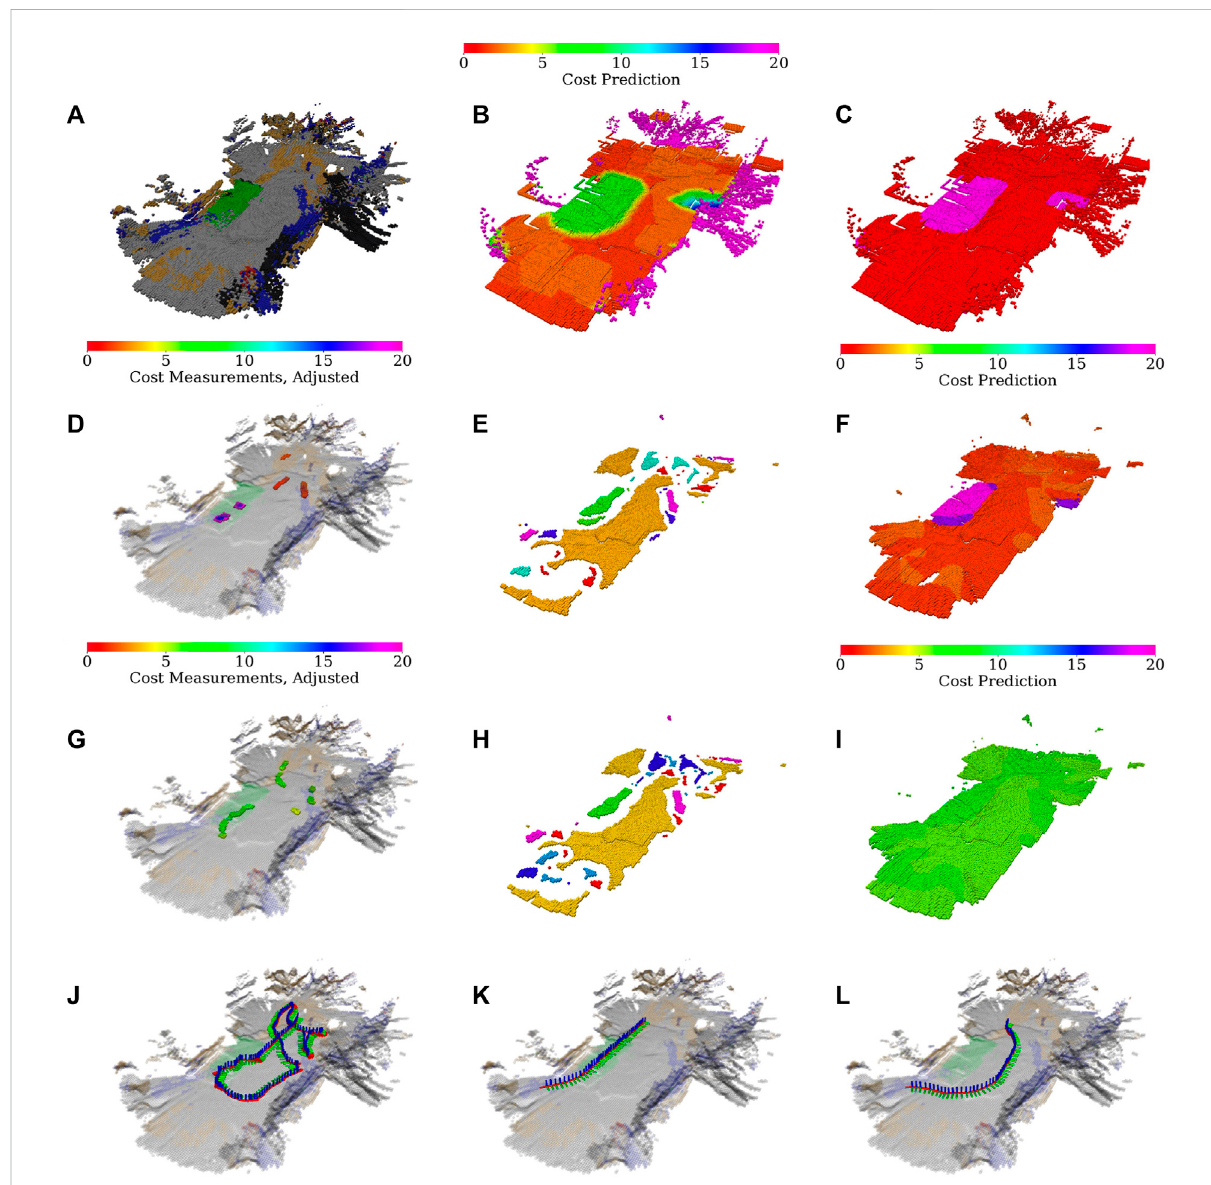
FIGURE 10 Environment evaluation and the real robot exploration run; (A) dominant color in the histogram feature; (B) merged cost used for planning; (C) selected gait ( fast in red, tall in purple); (D) costs used for learning the fast gait model (adjusted by hyperbolic tangents), visualized over the terrain appearance; (E) clusters used in the fast gait model (arbitrary colors used to distinguish clusters); (F) fast gait cost predictions assigned by the dilated clusters; (G) costs used for learning the tall gait model (adjusted by hyperbolic tangents), visualized over the terrain appearance; (H) clusters used in the tall gait model (arbitrary colors used to distinguish clusters); (I) tall gait cost predictions assigned by the dilated clusters; (J) exploration run; (K) test-tour run using the baseline model without the learned traversal costs; (L) test-tour run using the learned traversal